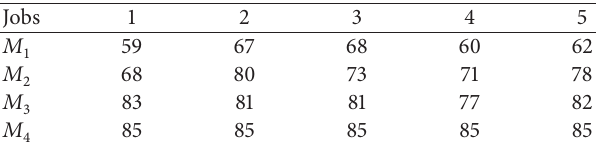
Table 8: Initial values of deadlines of Example